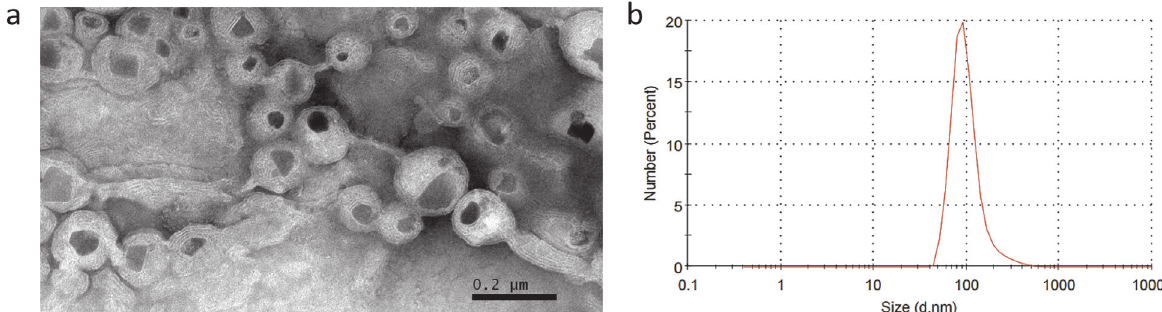
Figure 1 - ( a ) Image obtained by transmission electron microscopy. Bar corresponds to 200 nm. ( b ) The average size distribution of the nanoliposomes is represented in the